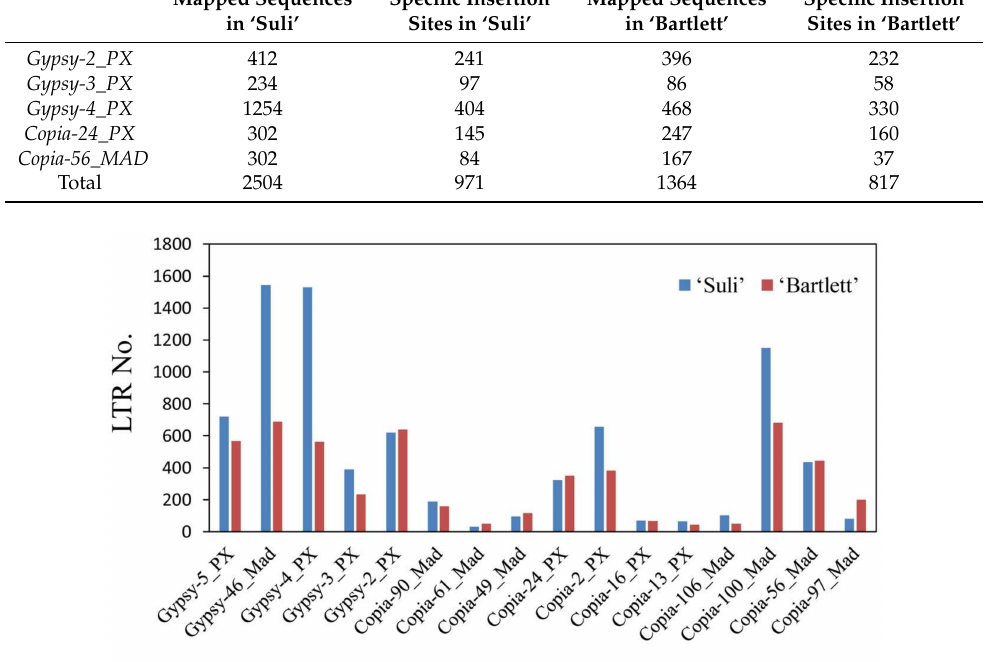
Table 3. The specific insertion sites in ‘Suli’ and ‘Bartlett’ based on five isolated LTR-RTs.